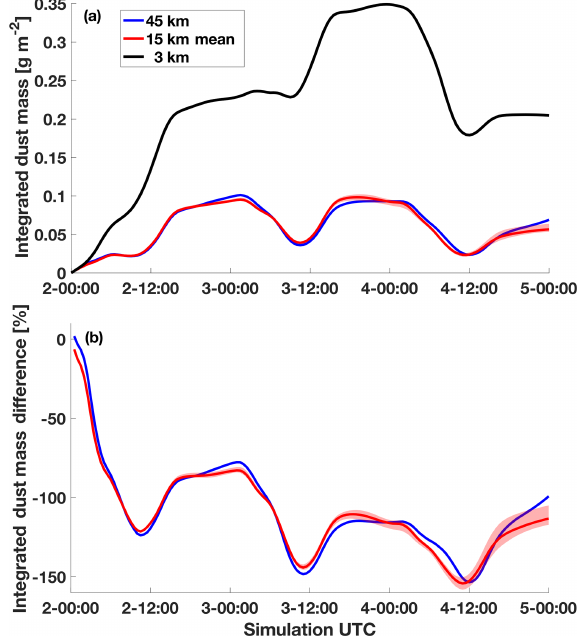
Figure 6. Spatially averaged, vertically integrated dust mass. Colors and shading are identical to those used previous